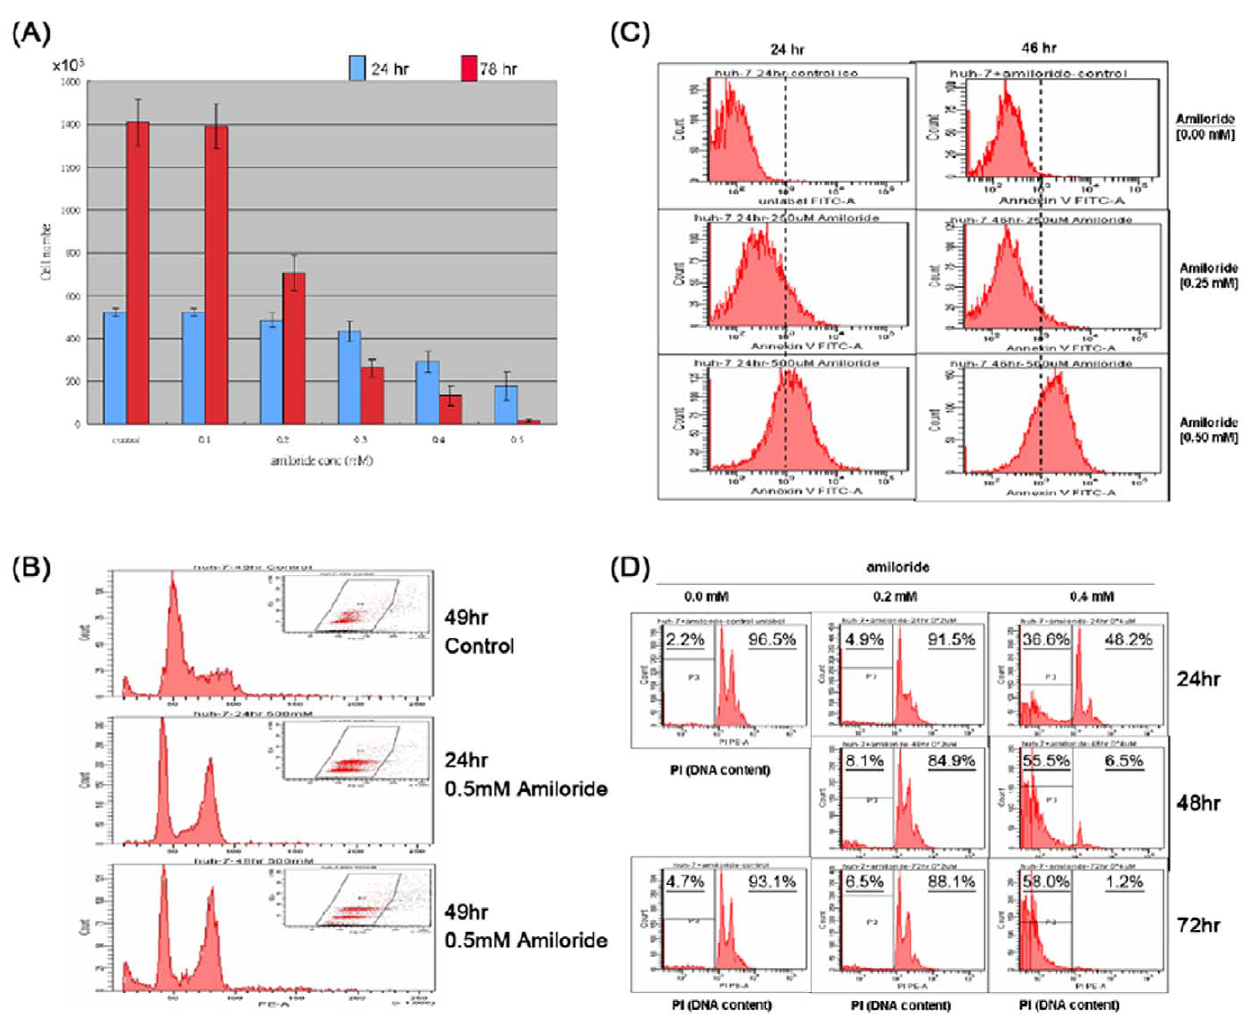
Figure 7. Growth inhibitory and apoptotic/cytotoxic consequences of amiloride-induced AS alterations. ( Panel A ) Huh-7 cells plated in 6-well dishes at 3 6 10 5 cells per well overnight were changed to growth medium containing various concentrations of amiloride; cell numbers were determined one and three days later. Cell counts at 24 hours show growth inhibition by amiloride at 0.4 mM and above. Further cell count decreases were evident at 72 hours due to cell death and detachment in medium containing amiloride at 0.3 mM and above. ( Panel B ) Cytofluorometric analysis shows amiloride inhibition of cell cycle progression with accumulation of G2/M phase cells. ( Panel C ) Apoptosis is evident by cytofluorometric detection of annexinV binding in Huh-7 cells treated with 0.5 mM of amiloride. ( Panel D ) Marked nuclear DNA degradation was observed in Huh-7 cells treated with 0.4 mM amiloride but not with 0.2 mM amiloride, particularly noted at 48 and 72 hours.